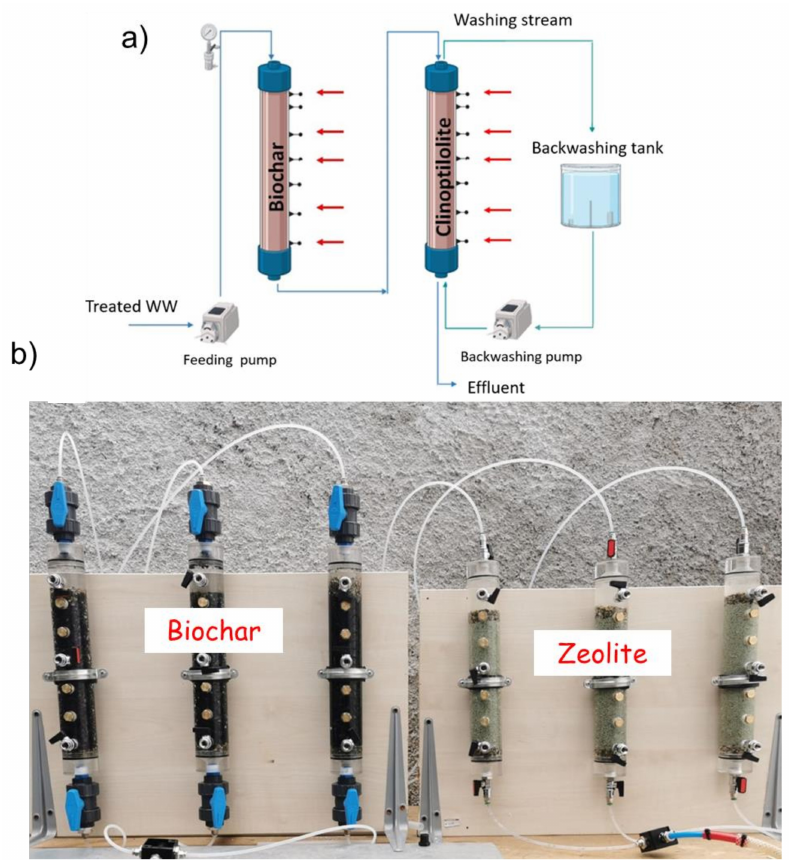
Figure 7. ( a ) Operating columns scheme; ( b ) filled columns with biochar and zeolite.